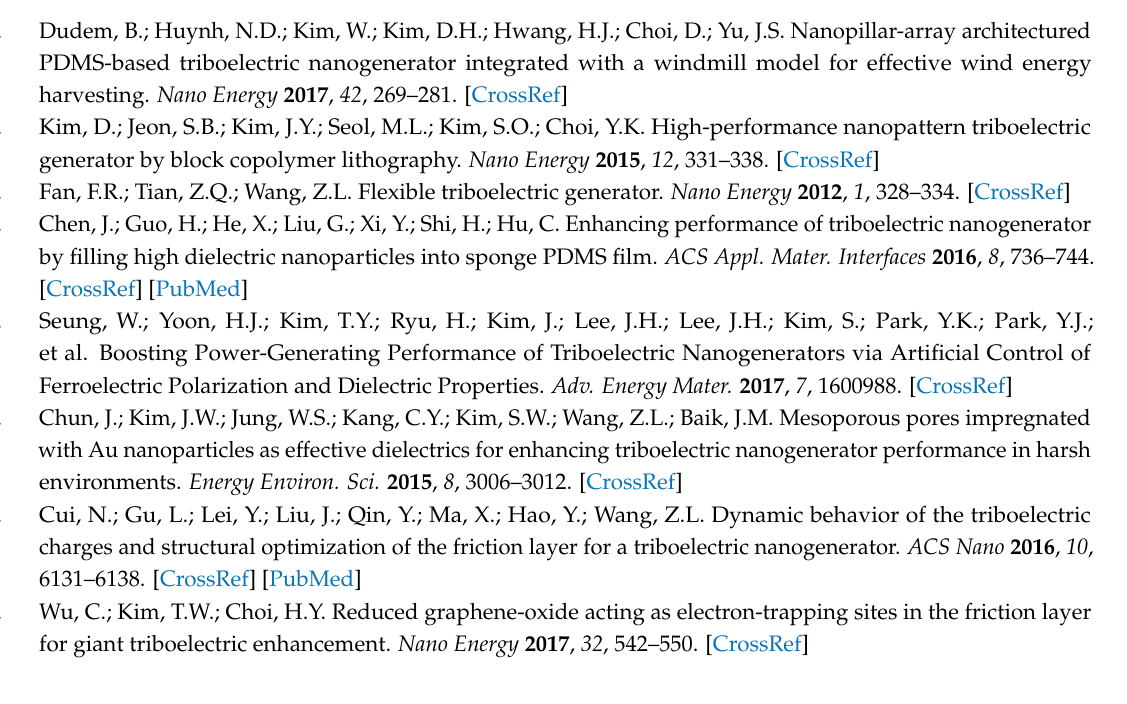
Figure S1: Schematic of the fabrication process for TiO 2 − x NPs embedded TENG, Figures S2: TENG performance according to the different applied input forces, Figures S3: Change of oxygen deficient states with various TiO 2 − x NP concentrations, Figures S4: Leakage current characteristics of PDMS layer as a function of TiO 2 − x NPs embedded